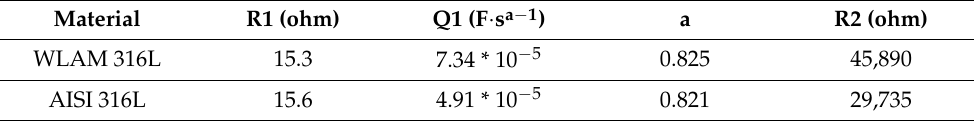
Figure 7. Nyquist diagram for electrochemical impedance spectroscopy analysis of the WLAM sample and its counterpart AISI 316L alloy. Table 5. Parameters of EIS analysis presented in Figure 7.